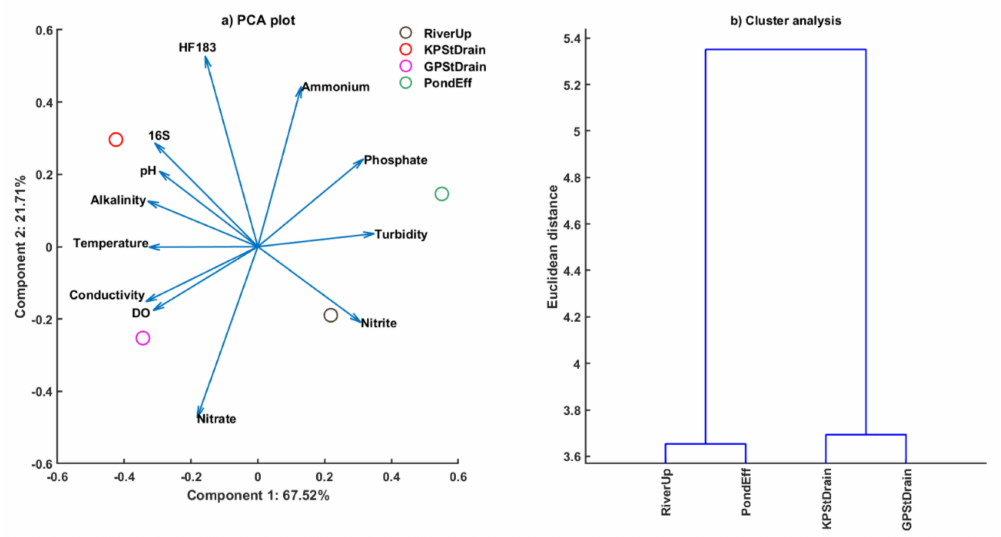
Figure 5. Multivariate analysis of the zscore transformed data collected onsite. Mean values of onsite qPCR assays and cuvette tests, and stabilized readings of the handheld probes are shown in the